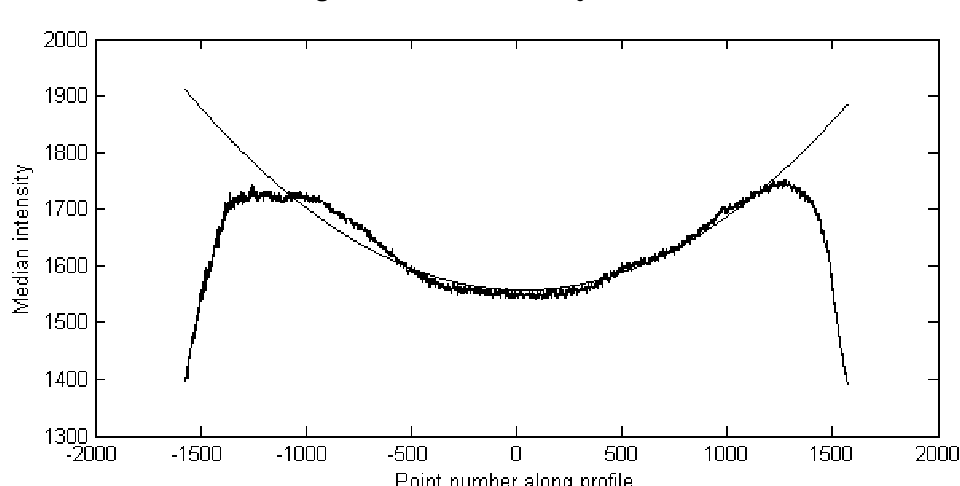
Figure 3. Fitted intensity